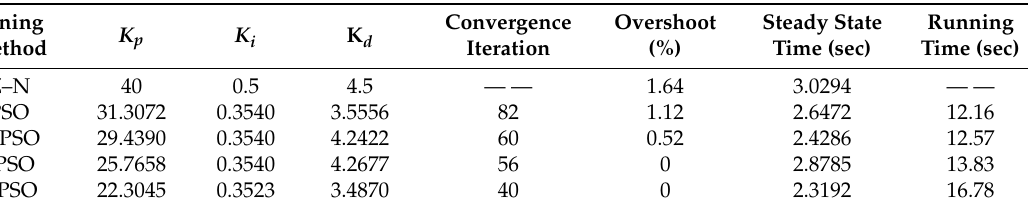
Table 1. Simulation results using Ziegler–Nichols (Z-N), particle swarm algorithm (PSO), linearly changed weight for particle swarm algorithm (WPSO), stable cross probability for particle swarm algorithm (SPSO), adaptively cross probability for particle swarm algorithm (APSO).